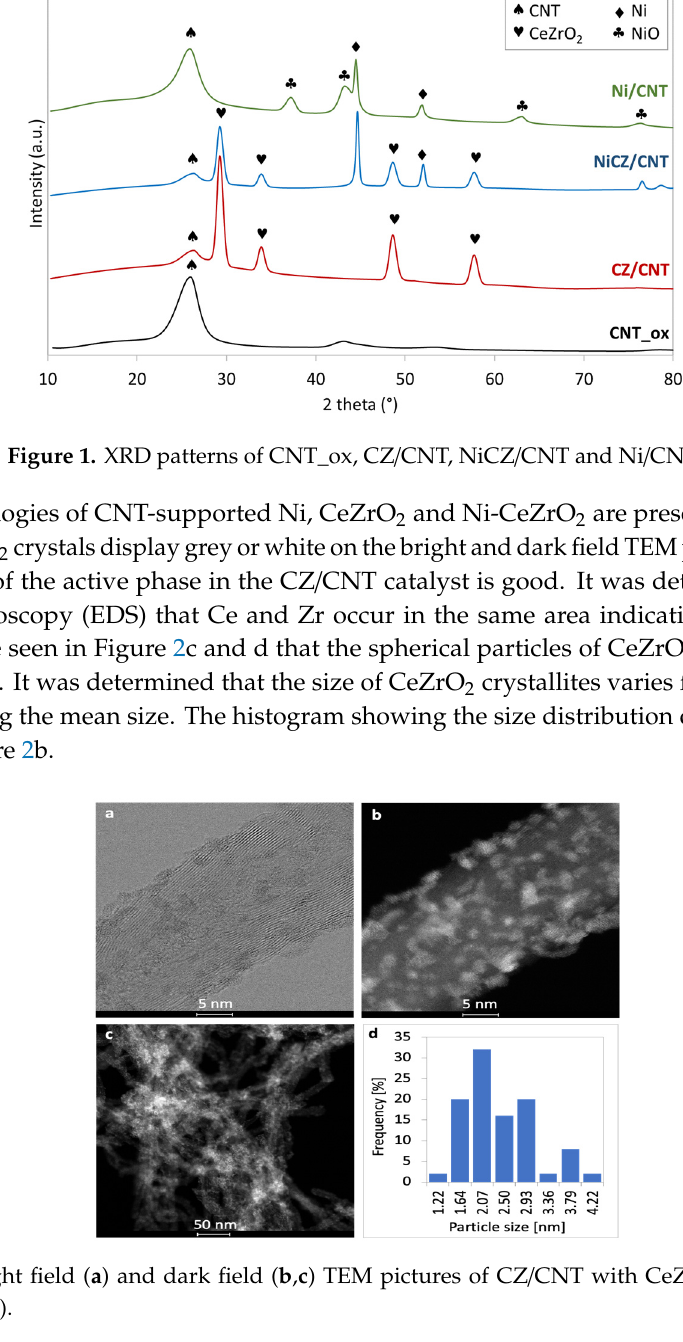
Figure 1. XRD patterns of CNT_ox, CZ/CNT, NiCZ/CNT and Ni/CNT.